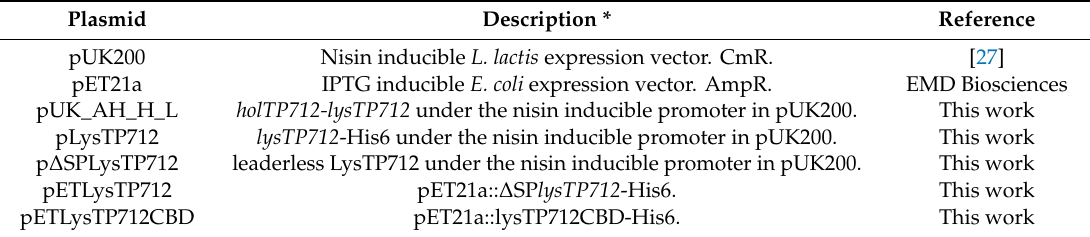
Table 2. Plasmids used in this